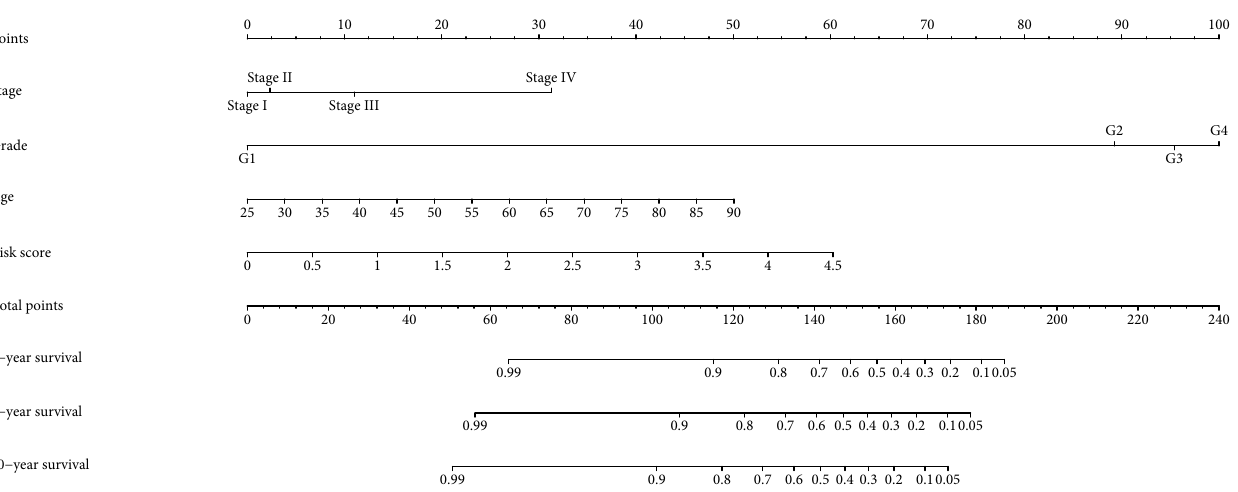
Figure 8: Nomogram to predict 5-year, 7-year, and 10-year OS of ccRCC